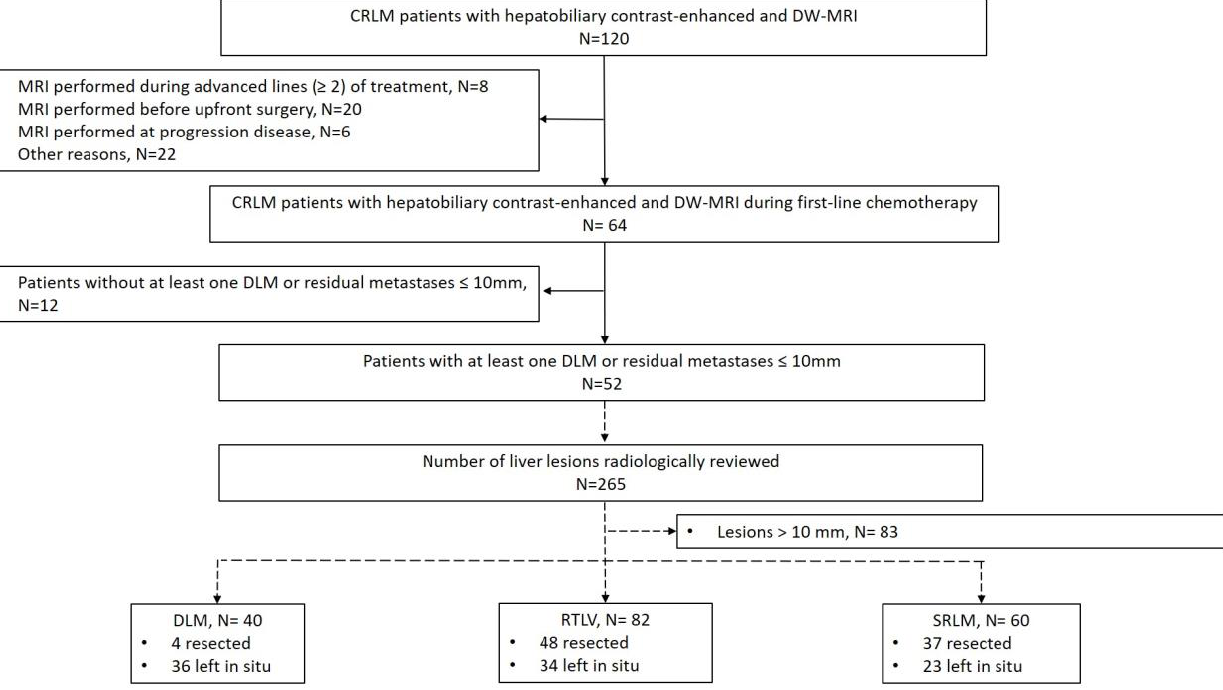
Figure 1. CRLM patients’ flowchart.